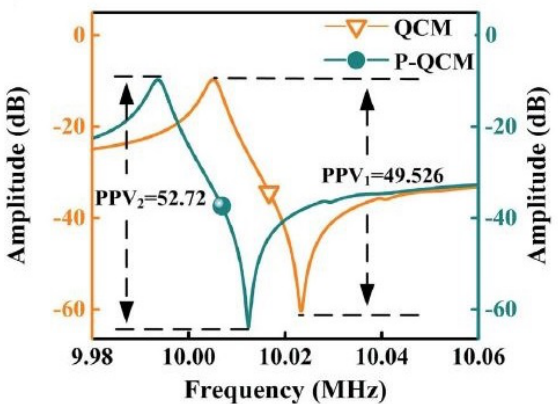
Figure 23. Evaluation of peak-to-peak value between typical QCM and Parylene-C coated QCM in air. Reprinted from Biosensors and Bioelectronics, 98, Yang et al., Stability enhanced, repeatability im- proved Parylene-C passivated on QCM sensor for aPTT measurement, 41–46, (2017), with